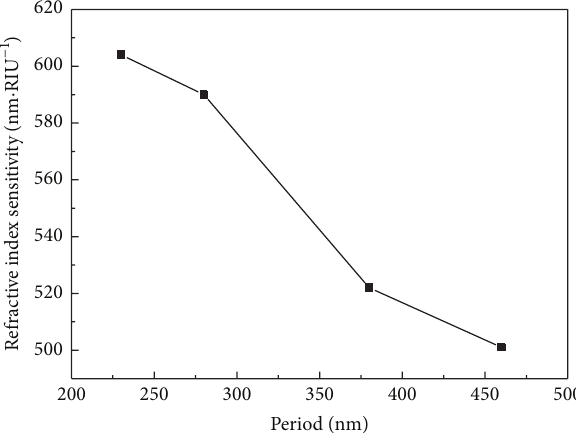
Figure 6: Refractive index sensitivity of the triangular Ag nanopar- ticle arrays with different periods.